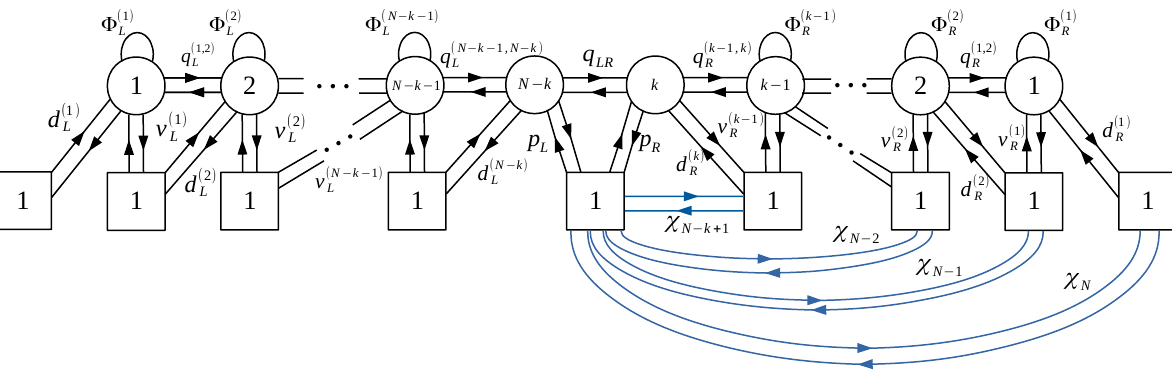
Figure 9 . Quiver diagram of the magnetic theory. The blue lines represent gauge singlets that transform under the (cid:13)avor symmetries of the nodes they